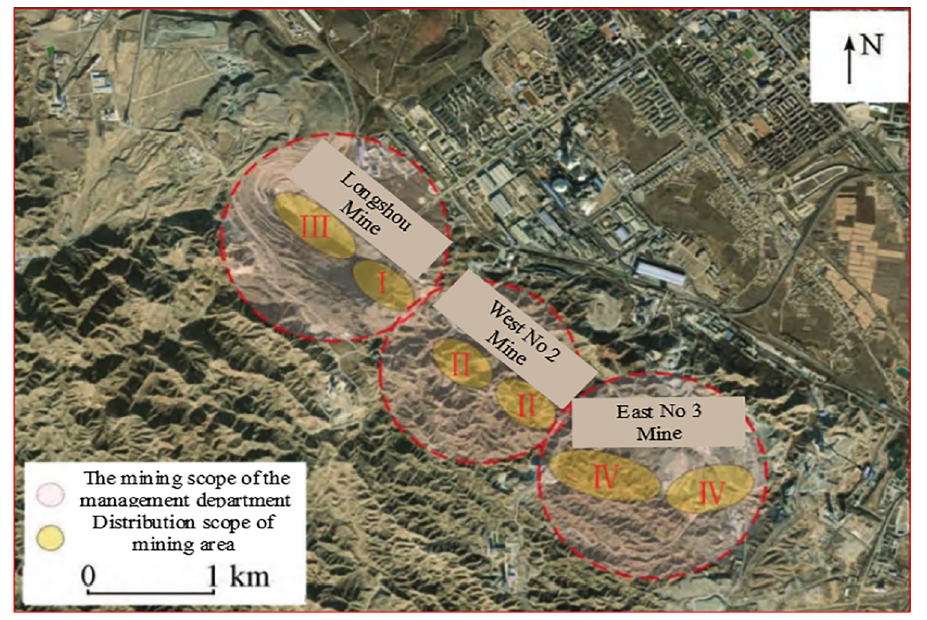
Fig 4. Mining distribution map of Jinshan Mining area.